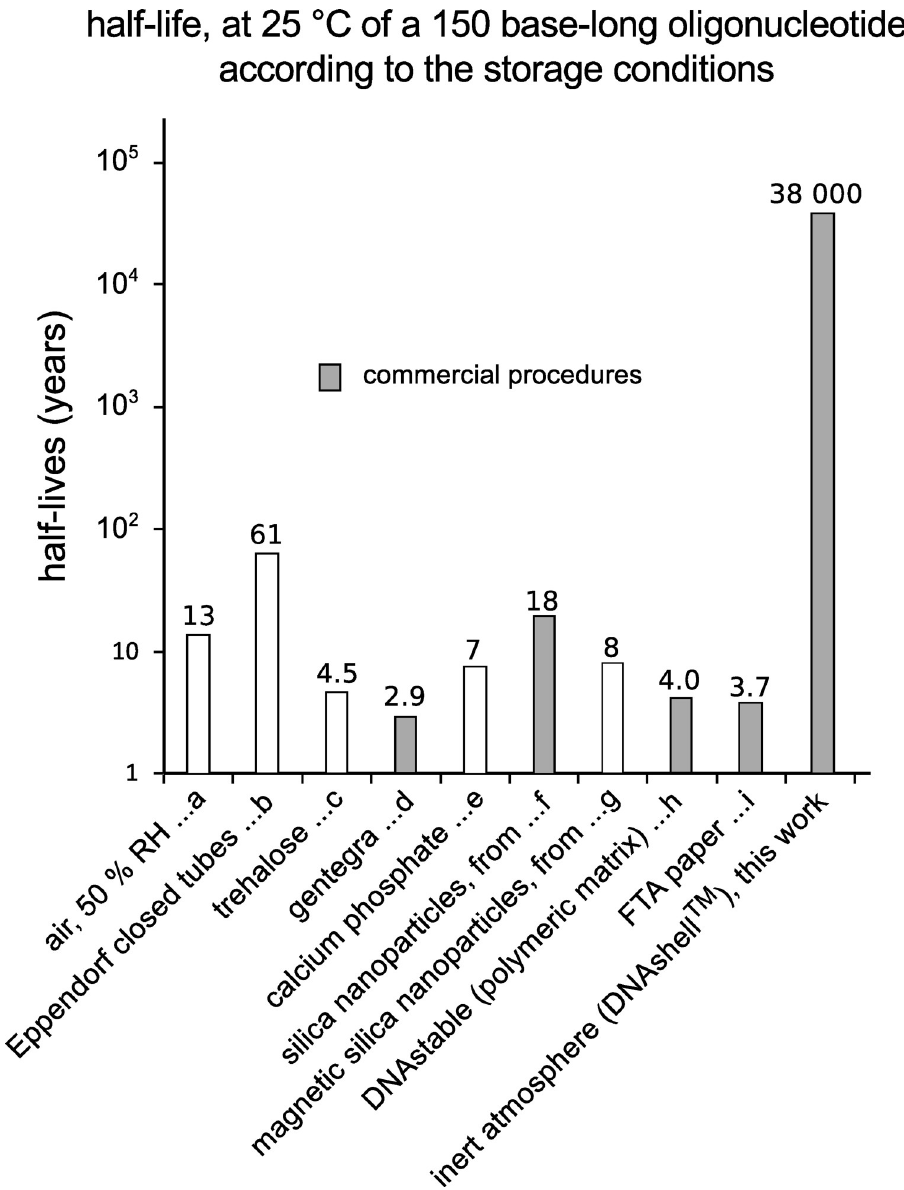
Fig 6. Half-lives of a 150 nucleotides long DNA fragment stored in various conditions. The half-life of a DNA sample left unprotected from the atmosphere at room temperature (a) or in an Eppendorf closed tube (b) has been calculated from our previous work [7]. The one of a sample encapsulated in silica nanoparticles (g), deposited on FTA card paper (i) or included in Biomatrica DNAstable (h) has been estimated from [28] (Fig 2B). The half-life of DNA dried with calcium phosphate (e) and encapsulated in magnetic silica nanoparticles (f) have been estimated, respectively from [29] (Fig 3B) and [19] (Fig 5) assuming an exponential decay and an activation energy of 155 kJ/mol. The half-life for DNA stored in Gentegra (d) or trehalose (c) was taken from [29] (Fig 2B). In grey: Current commercialized